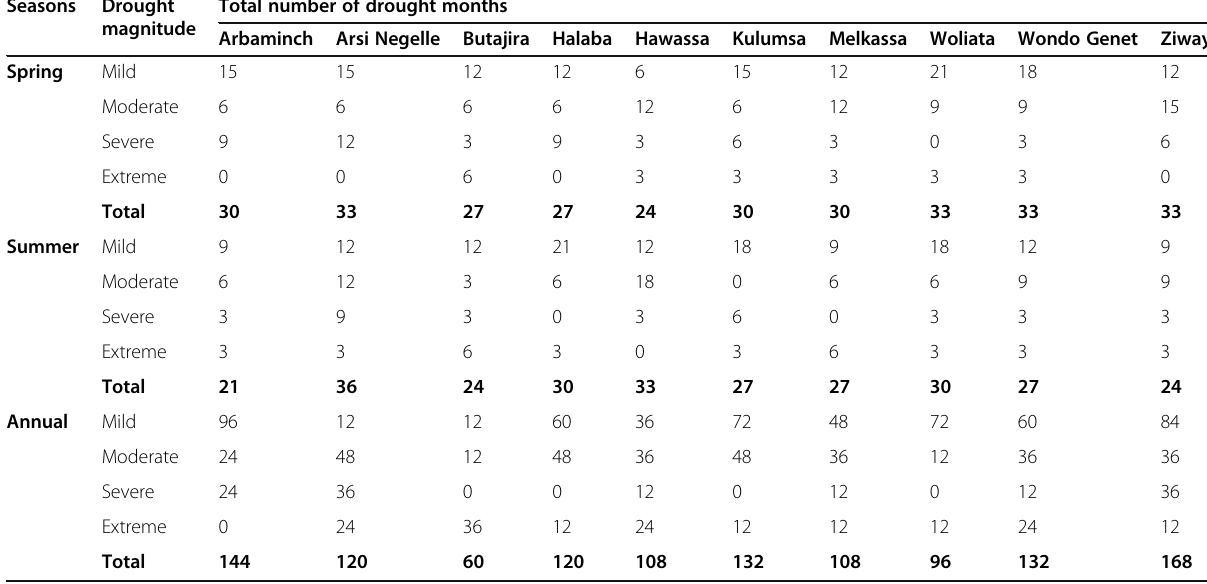
Table 2 Magnitude and frequency of drought events for spring, summer and annual timescale Seasons Drought Total number of drought months magnitude Spring